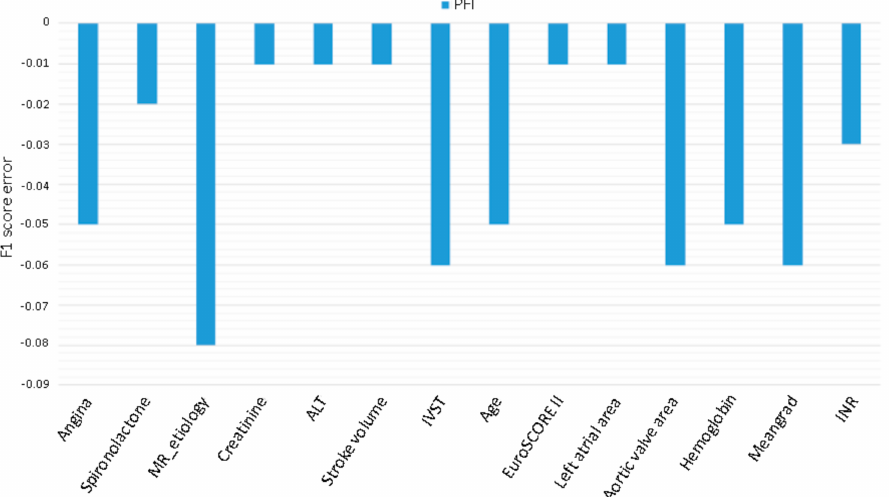
Figure 5. Permutation feature importance permutation feature importance (PFI) method. More relevant features are associated with more negative values. MR, mitral regurgitation; ALT, alanine aminotransferase; IVST, interventricular septal thickness; Meangrad, mean aortic pressure gradient; INR, international normalized